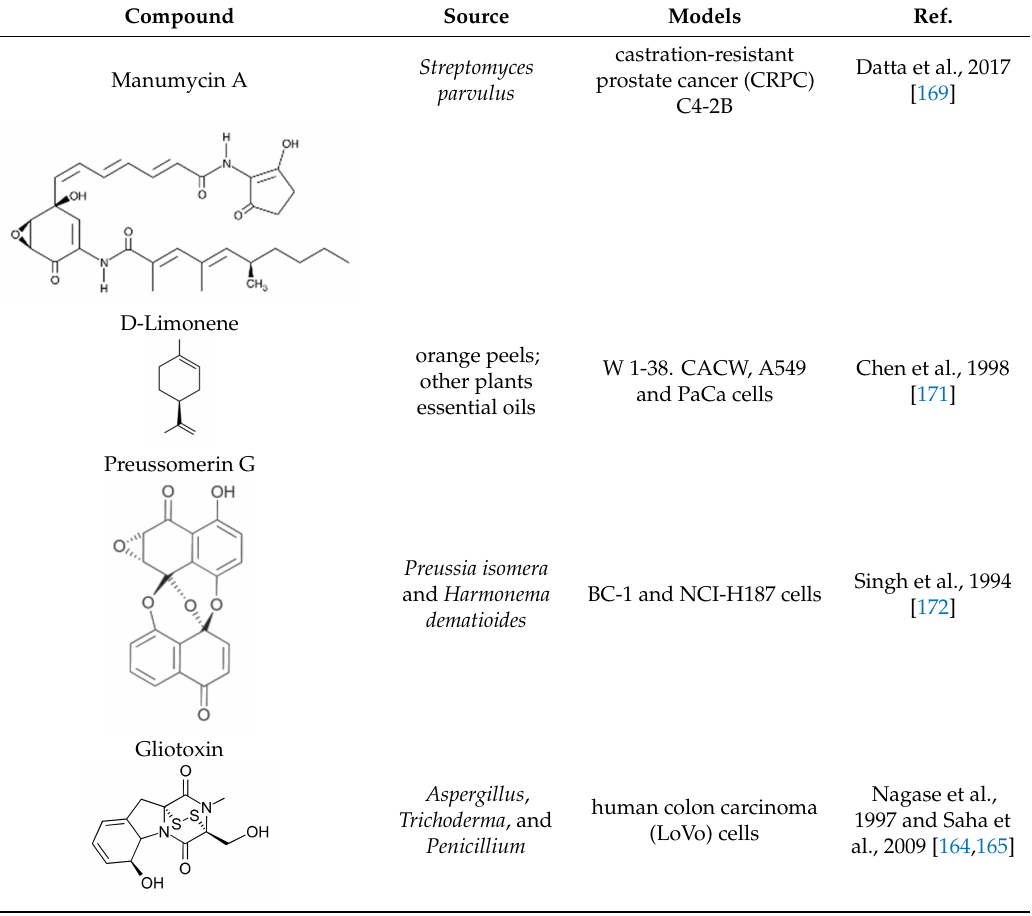
Table 2. List of natural compounds indirectly a ff ecting Ras oncoprotein activity by interfering with Ras prenylation. Compound Source Models